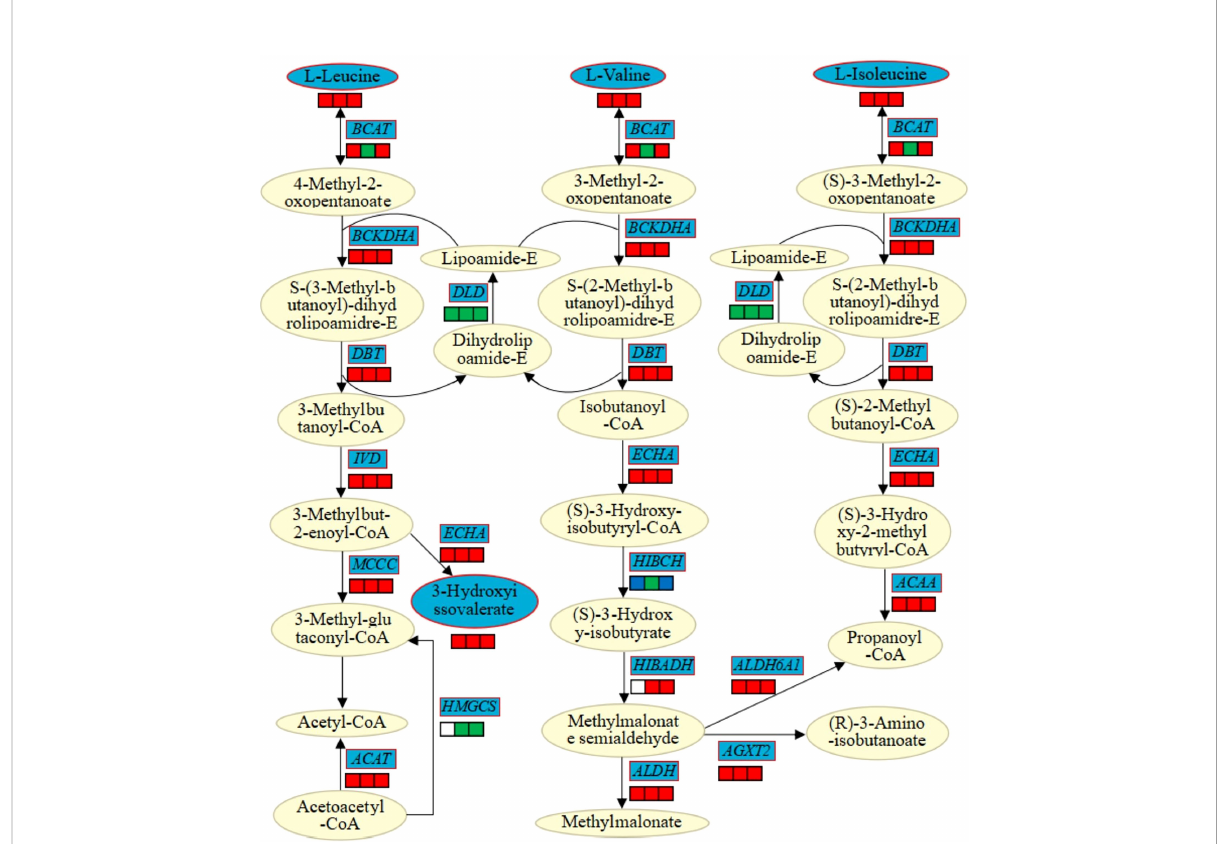
FIGURE 6 The DEGs and DAMs involved in the pathway of valine, leucine and isoleucine degradation in response to Cd stress and the addition of MT. BCAT , branched-chain amino acid aminotransferase; BCKDHA , 2-oxoisovalerate dehydrogenase E1 component alpha subunit; DLD , dihydrolipoamide dehydrogenase; DBT , 2-oxoisovalerate dehydrogenase E2 component (dihydrolipoyl transacylase); IVD , isovaleryl-CoA dehydrogenase; ECHA , enoyl-CoA hydratase; MCCC , 3-methylcrotonyl-CoA carboxylase alpha subunit; ACAT , acetyl-CoA C-acetyltransferase; HMGCS , hydroxymethylglutaryl-CoA synthase; HIBCH , 3-hydroxyisobutyryl-CoA hydrolase; HIBADH , 3-hydroxyisobutyrate dehydrogenase; AGXT2 , alanine-glyoxylate transaminase/(R)-3-amino-2- methylpropionate-pyruvate transaminase; ALDH , aldehyde dehydrogenase (NAD+); ALDH6A1 , malonate-semialdehyde dehydrogenase (acetylating)/methylmalonate-semialdehyde dehydrogenase; ACAA , acetyl-CoA acyltransferase. The blue pattern represents the DEGs or DEGs that changed under Cd stress and the addition of MT. The rectangle is divided into three equal parts (the left of rectangle represents DEGs or DEMs in CK vs T1, the middle of rectangle represents DEGs or DEMs in CK vs T2, the right of rectangle represents DEGs or DEMs in CK vs T3). The color in the rectangle represents the DEGs or DEMs are regulated under Cd stress and the addition of MT (red indicates up-regulation, green indicates down-regulation, blue indicates both up-regulation and down- regulation, white indicates neither up-regulation nor